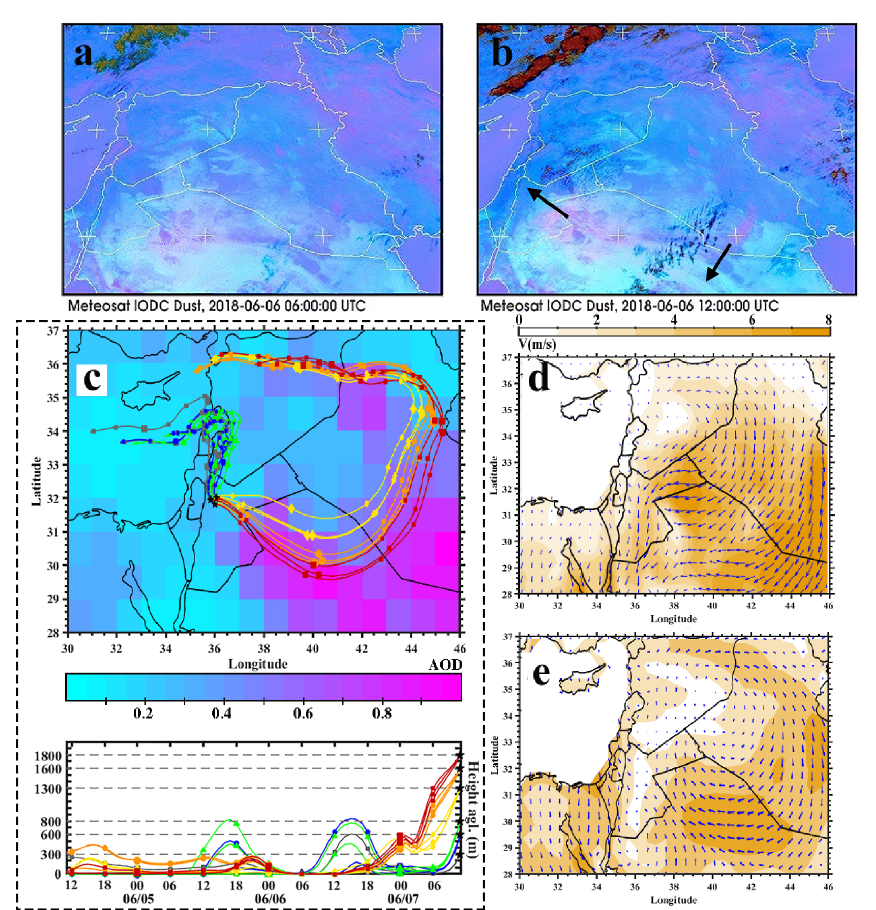
Figure 5. ( a ) SEVIRI false-color images at 06:00 UTC and ( b ) 12:00 UTC on 6 June 2018. In these RGB images, clouds appear in orange or brown, dust in magenta or pink, sandy regions in white, and dry land in pale blue. ( c ) Backward trajectories during the past 72 h by the HYSPLIT model on 7 June 2018 calculated at different heights and overlaid by MODIS Deep Blue AOD. ( d , e ) Corresponding surface wind speed and direction at 06:00 UTC and 12:00 UTC by the ECMWF